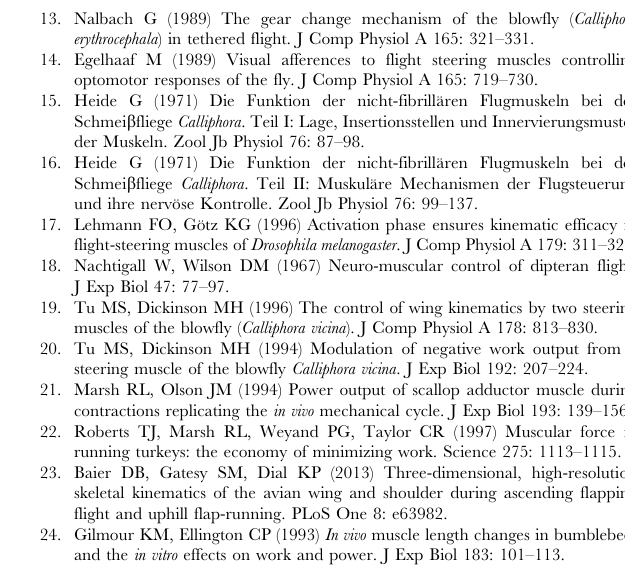
stages of the wingbeat, starting at the beginning of the downstroke. The steering muscles are viewed from the inside of the thorax looking out toward the wing hinge, and other parts of the thorax have been removed for clarity. The view of the low-amplitude (right) wing muscles has been mirrored about the sagittal plane of the insect for ease of comparison. The basalare sclerite is not visible directly in the reconstruction, but its position can be inferred by the intersection of the b1 and b3 steering muscles. See main text and Figure 6 for labeling of muscles. This video can be viewed at http://youtu.be/ehG4G-NOTQg. (MOV) Movie S3 Three-dimensional visualizations of the ex- ternal movement of the thorax. Differences in the deforma- tions of the thorax and the movement of the basalare sclerite are shown for the high-amplitude (left) and low-amplitude (right) wings through ten stages of the wingbeat, starting at the beginning of the downstroke. The low-amplitude (right) view has been mirrored about the sagittal plane of the insect for ease of comparison. See main text and Figure 7 for anatomical details. This video can be viewed at https://www.youtube.com/watch?v = Cxc3yZIsbqo &feature =